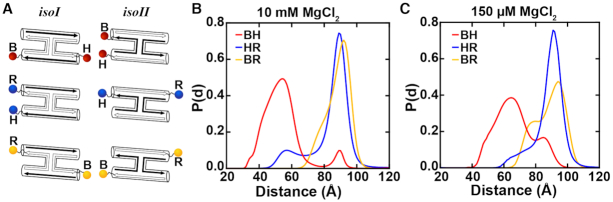
XSI Holliday junction constructs and measured distance distributions at high and intermediate divalent salt. (A) Schematic of the stacked states isoI and isoII of the Holliday junction and of the different label pairs (BH, HR, and BR). Distance distributions for the label pairs BH (red), HR (blue) and BR (yellow) recorded at (B) high (10 mM MgCl2 and 30 mM Tris, pH 7.4) and (C) intermediate divalent salt concentration (150 μM MgCl2 and 30 mM Tris, pH 7.4). The observation of multiple peaks is indicative of the presence of different states at each salt condition (see Supplementary Figures S4–S7, S8, S9). Distributions in (B) and (C) are normalized.